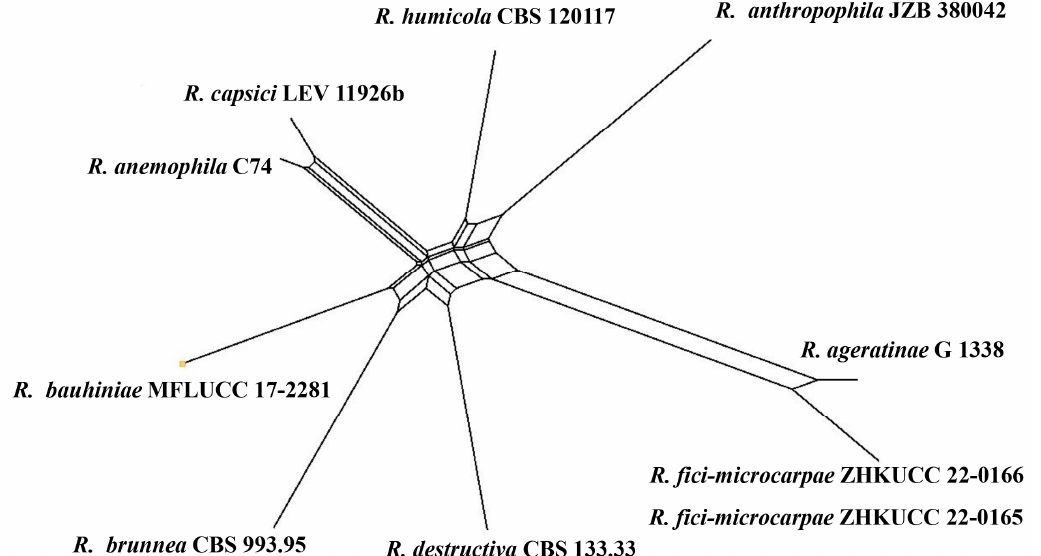
Figure 7. The results of a PHI test of closely related taxa ( Remotididymella clade) using both LogDet transformation and splits decomposition. PHI test results. Φ w = 0.26.